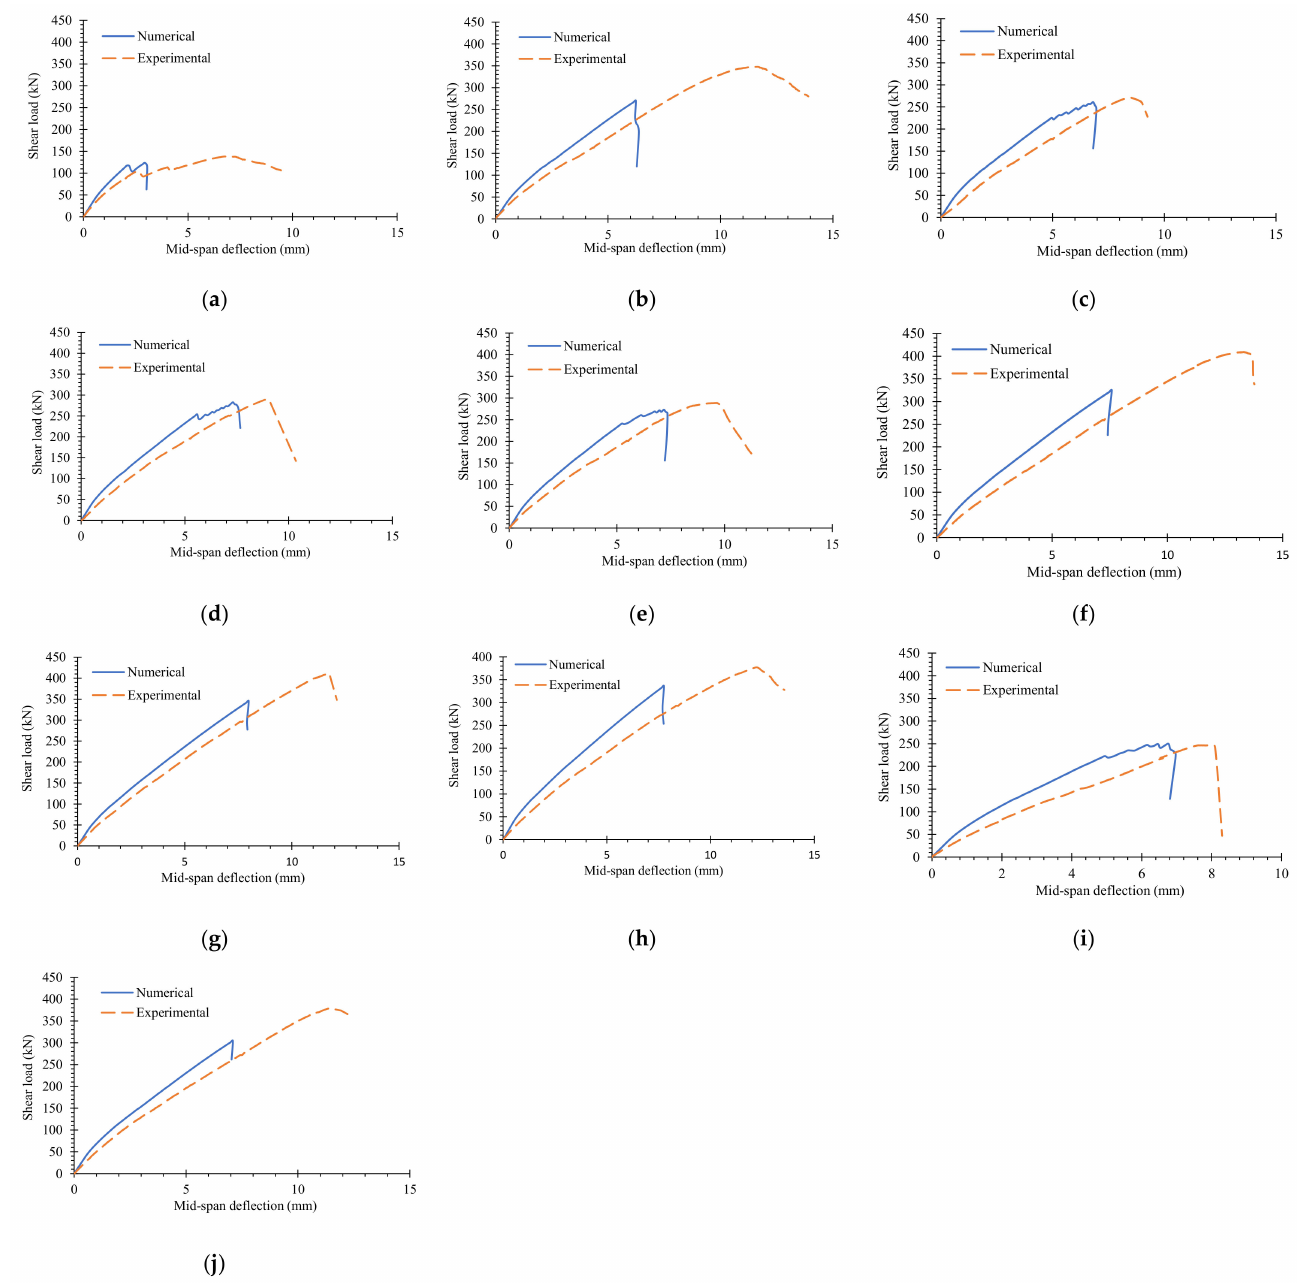
Figure 19. Numerical versus experimental response: ( a ) Control-NS; ( b ) Control-ST; ( c ) NS-C1-90; ( d ) NS-C2-90; ( e ) NS-C2-0/90; ( f ) ST-C1-90; ( g ) ST-C2-90; ( h ) ST-C2-0/90; ( i ) NS-G1-90; ( j )